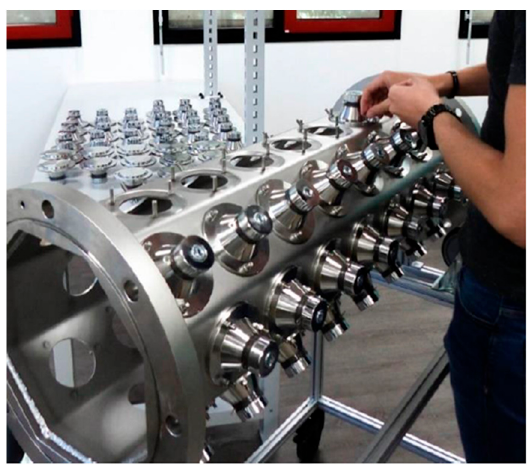
Figure 8. Installation of the transducers at Cedrat Technologies.